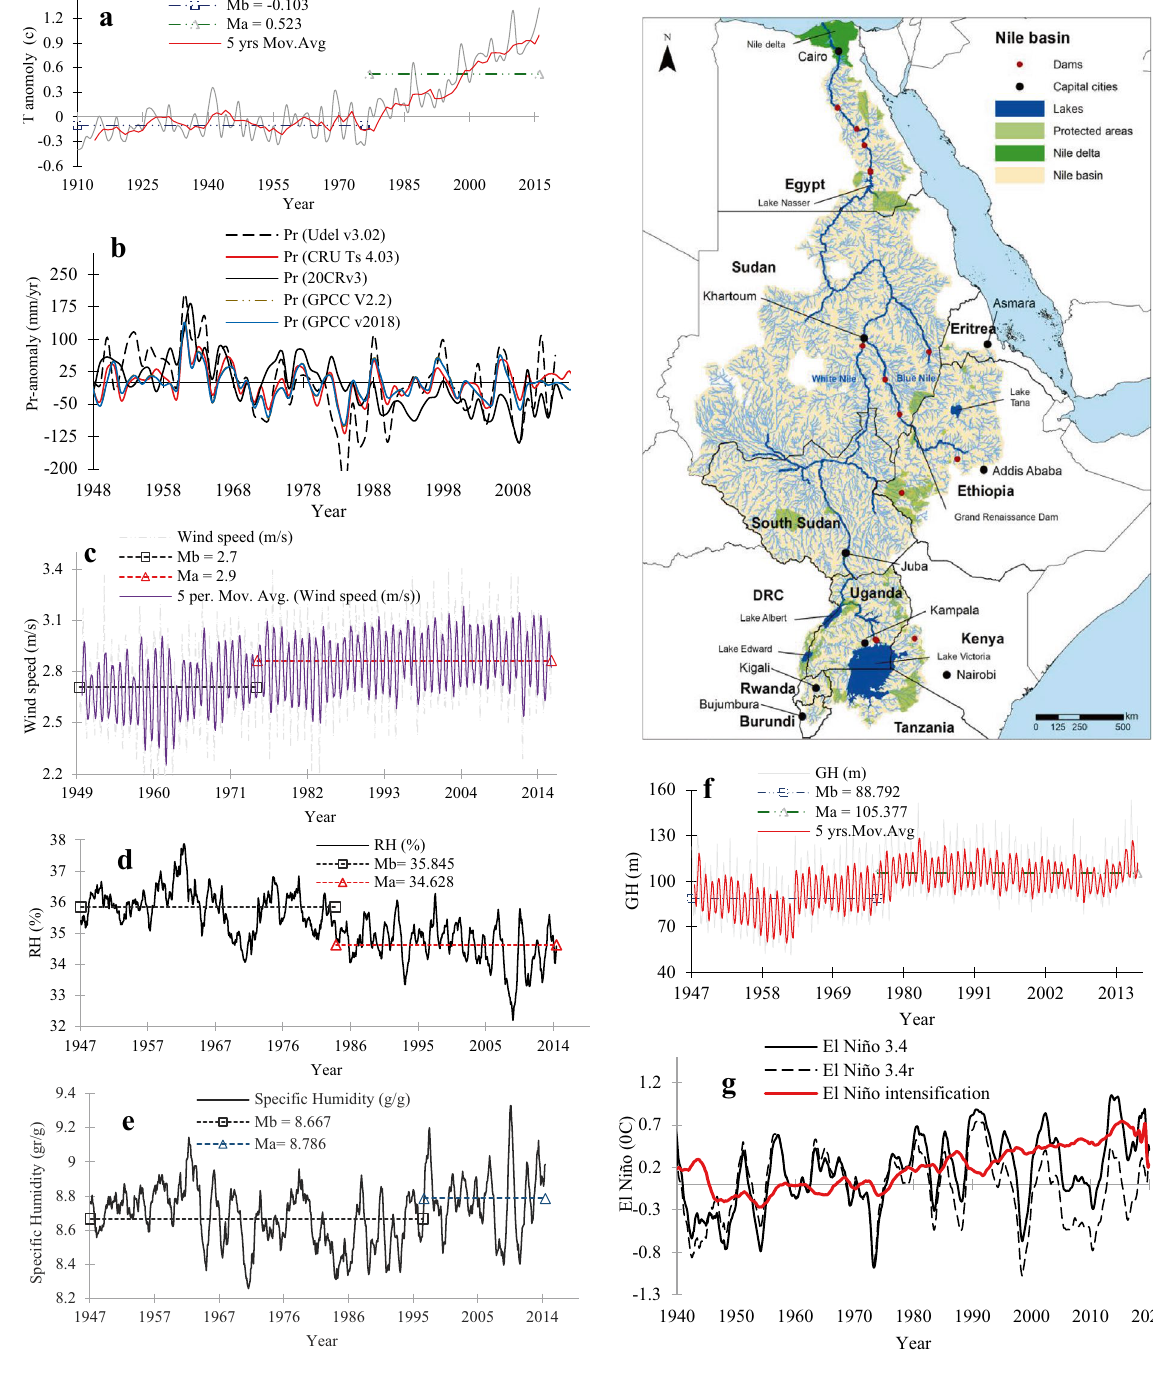
Figure 1. A detailed map of the Nile River Basin (NRB) basin showing the main riparian of the Nile generated with ArcMap Version 10.1 (http:// www. esri. com/ en/ arcgis/ arcgis- for- deskt op/). The observed streamflows analysed are taken from the Blue Nile station in Khartoum, Dongola station, and the Aswan station. The analysed hydroclimate data and drought index are averaged over the NRB, as well as for each riparian country of the Nile. Figure 1 shows: ( a ) temperature anomaly, where Mb is the long-term average before the change point, and Ma the long-term average after the change point. ( b ) precipitation anomaly from five different datasets, ( c ) wind speed, ( d ) relative humidity, ( e ) specific humidity, ( f ) geopotential height, and ( g ) ERSST relative (without global warming signal) and absolute El Niño3.4 index time series, Fig. 1g also shows El Niño3.4 intensification by global warming (red-line). Figure 1 also shows a decreasing trend in precipitation at 16.2 mm/decade since 1970s, increasing trend in wind speed and zonal wind stress at 0.02 m/decade and 1.51 m 2 /s 2 /decade respectively since 1975, increasing trend in geopotential height (GPH) at 3.1 m/decade since 1976, warming trend at 0.19 °C/ decade, and decreasing trend in relative humidity (RH) since